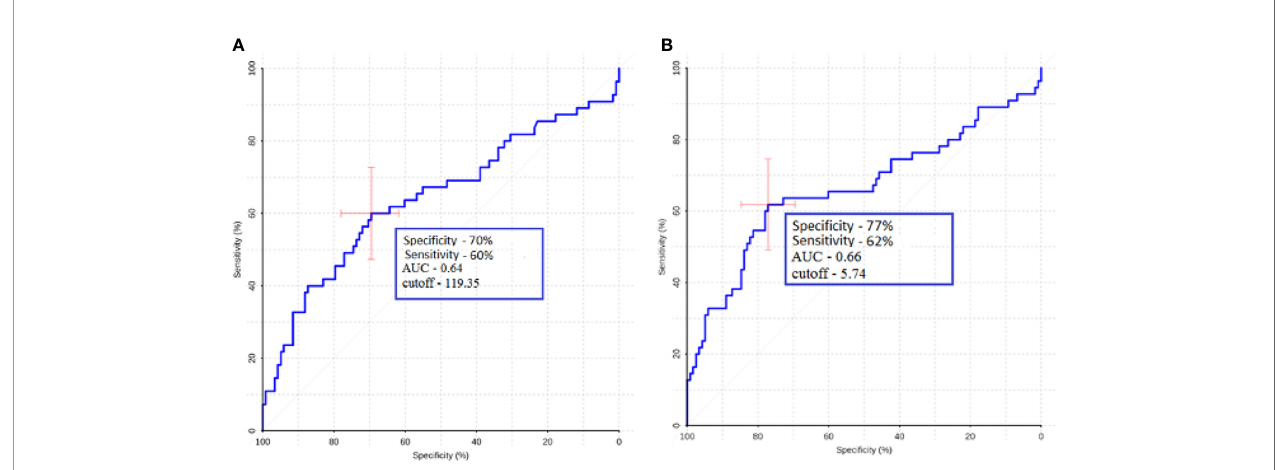
FIGURE 5 | ROC analysis data obtained by comparing the maximum (A) and normalized values (B) of intratumoral blood fl ow in the groups of metastases and glioblastomas. The values of the optimal threshold are presented, in brackets — speci fi city and sensitivity.